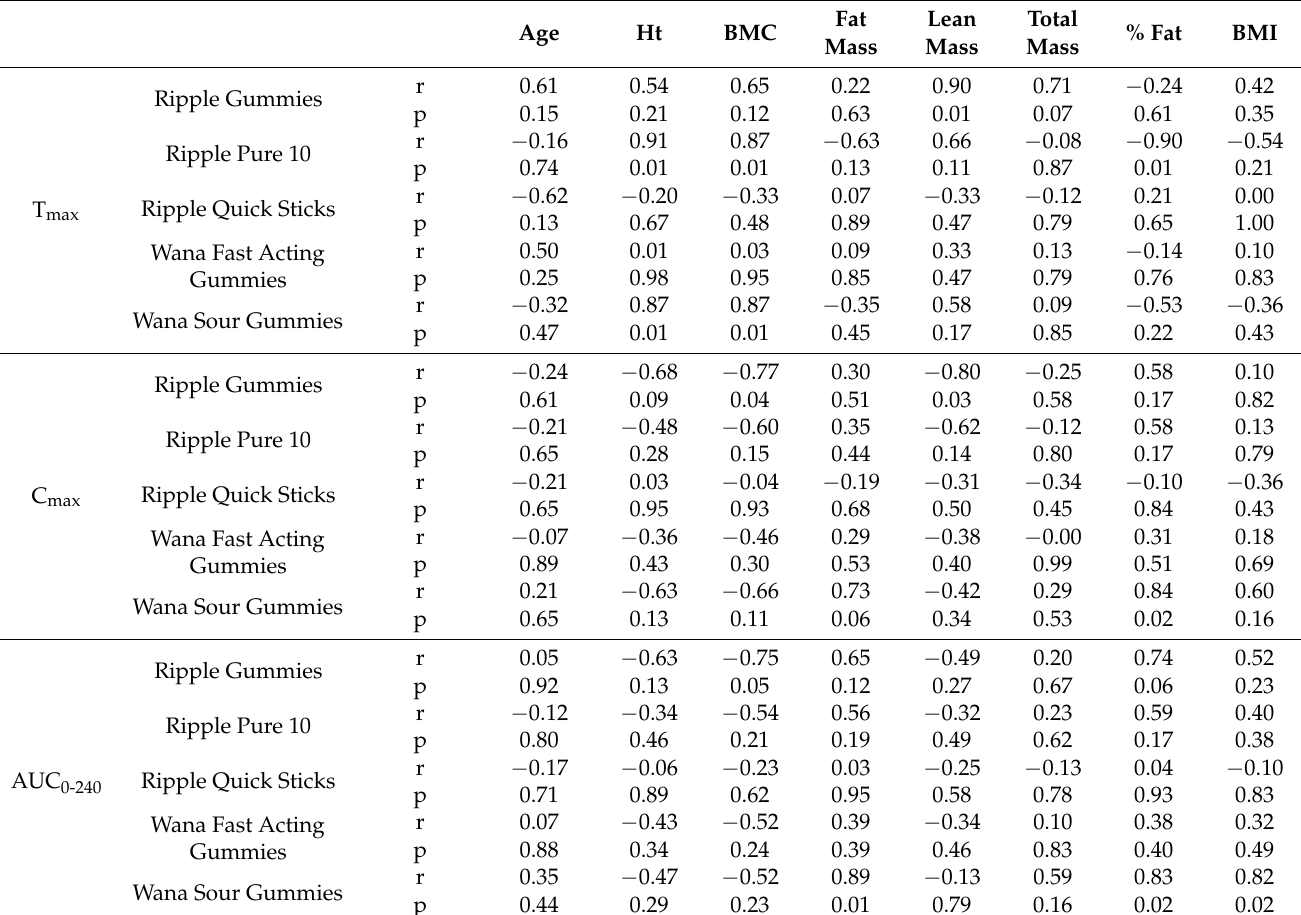
Table 7. Pearson correlations between parameters of body composition and THC pharmacokinetics.